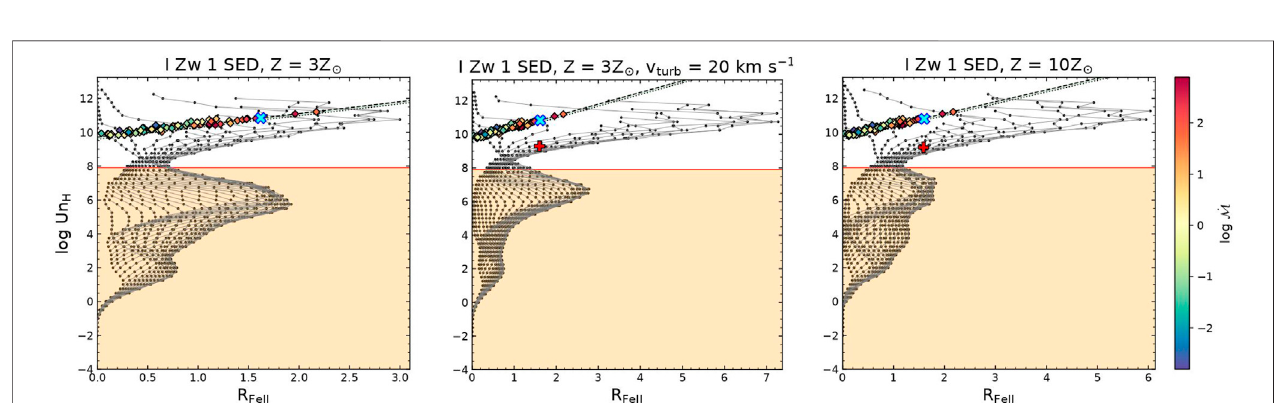
FIGURE5| Grid composed ofthefamily ofdistributionsfor Un H (in log-scale)asafunctionofR FeII (gray lines withblack dots) from oneofour CLOUDY simulations — I Zw 1SED, N H =10 24 cm − 2 and atsolarcomposition.Theshaded regioninorangedepicts theregionwithinthedust,andthesolidredlinemarksthelocationofthedust sublimationradiusasper Table2 .Thesampleof75reverberation-mappedsources(see SupplementaryTableS4 )isshownforthecorrespondingcasesofUn H asper thefouranalyticalformsshownin Table1 .Thesesourcesarecolor-codedwiththeircorresponding _ M estimates.ThelocationofthesourceIZw1isshownusinga blue cross for the lower panels in which there is an explicit dependence on the R FeII